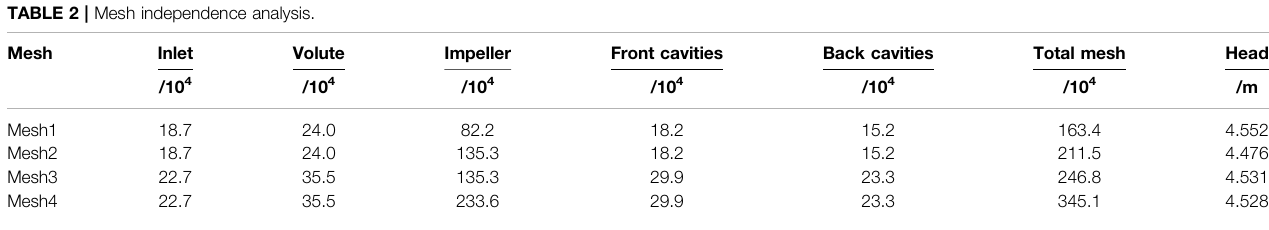
TABLE 2 | Mesh independence